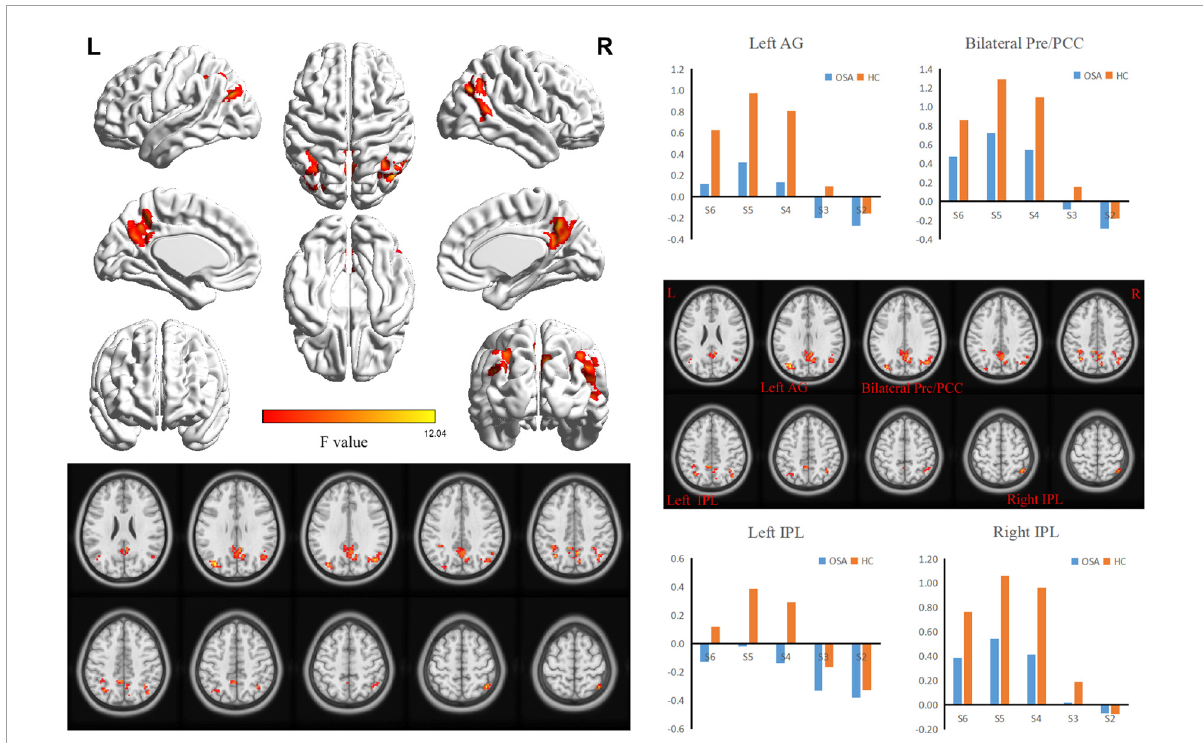
FIGURE2 The interaction between specific frequency bands (Slow-2 to Slow-6) and groups (OSA patients and HC) was based on ANOVA (flexible factorial design, 2 × 5, two-tailed, voxel level P < 0.01, GRF corrected, cluster level P < 0.05). AG, Angular Gyrus; Pre, Precuneus; PCC, posterior cingulate cortex; IPL, Inferior Parietal